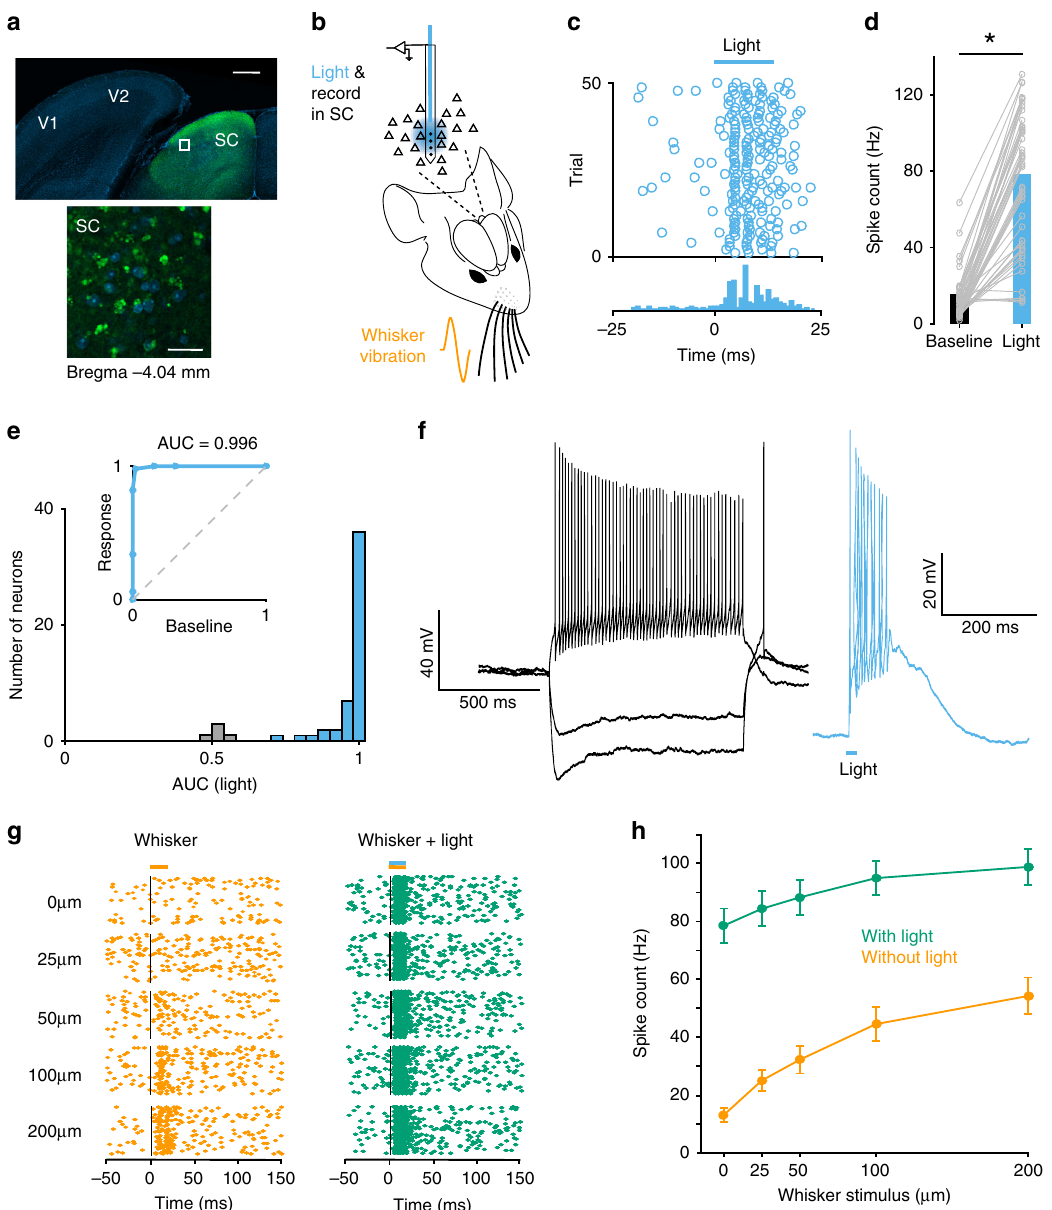
Fig. 1 Neurons in SC are reliably activated by light and whisker stimulation. a Coronal section showing injection site of ChR2-eYFP in SC (green). DAPI in blue. Scale bar 500 µ m. SC, superior colliculus; V1, primary visual cortex; V2, secondary visual cortex. Bottom: higher magni fi cation of the region delineated by the white square in the top image. Scale bar 25 µ m. b Schematic of the experimental arrangement. Extracellular recording and optogenetic activation in SC with or without whisker vibration. c Raster plot (top) and peri-stimulus time histogram (bottom) during extracellular recording from a neuron in the intermediate layer of SC using an optrode (2289 µ m from the surface of the brain) showing increased spiking in response to light activation (15 ms; blue bar). d Spiking activity of SC neurons ( n = 55) increases signi fi cantly during light activation. Asterisk represents p < 0.001 (Two-sided paired t -test). e Inset shows the ROC curve for a representative SC neuron during light stimulation (same neuron as in c ). The dashed line shows what is expected by chance. For this neuron, the area under the ROC curve (AUC) is 0.996. The main panel shows the distribution of AUC values for all neurons ( n = 55). Blue bars depict SC neurons with a signi fi cant increase in spiking in response to optogenetic stimulation ( n = 50). Gray bars depict SC neurons where there was no signi fi cant change in spiking ( n = 5). f Left: voltage responses of a ChR2 expressing neuron in SC to somatic current injection ( − 150, − 100, and 150 pA). Right: action potentials evoked in the same neuron in response to light (15 ms; LED power 0.3 mW). g Raster plot of action potential fi ring during extracellular recording from a SC neuron (2130 µ m from the surface of the brain) activated by whisker movement of different amplitude alone (orange dots; left) and with light (green dots; right). h Pooled data showing the impact of light activation (green) on the whisker input – output relationship of whisker responsive SC neurons (orange). Only neurons that were responsive to both whisker and SC stimulation were included in this analysis ( n = 40). Error bars represent SEM. Source data are provided as a Source Data fi